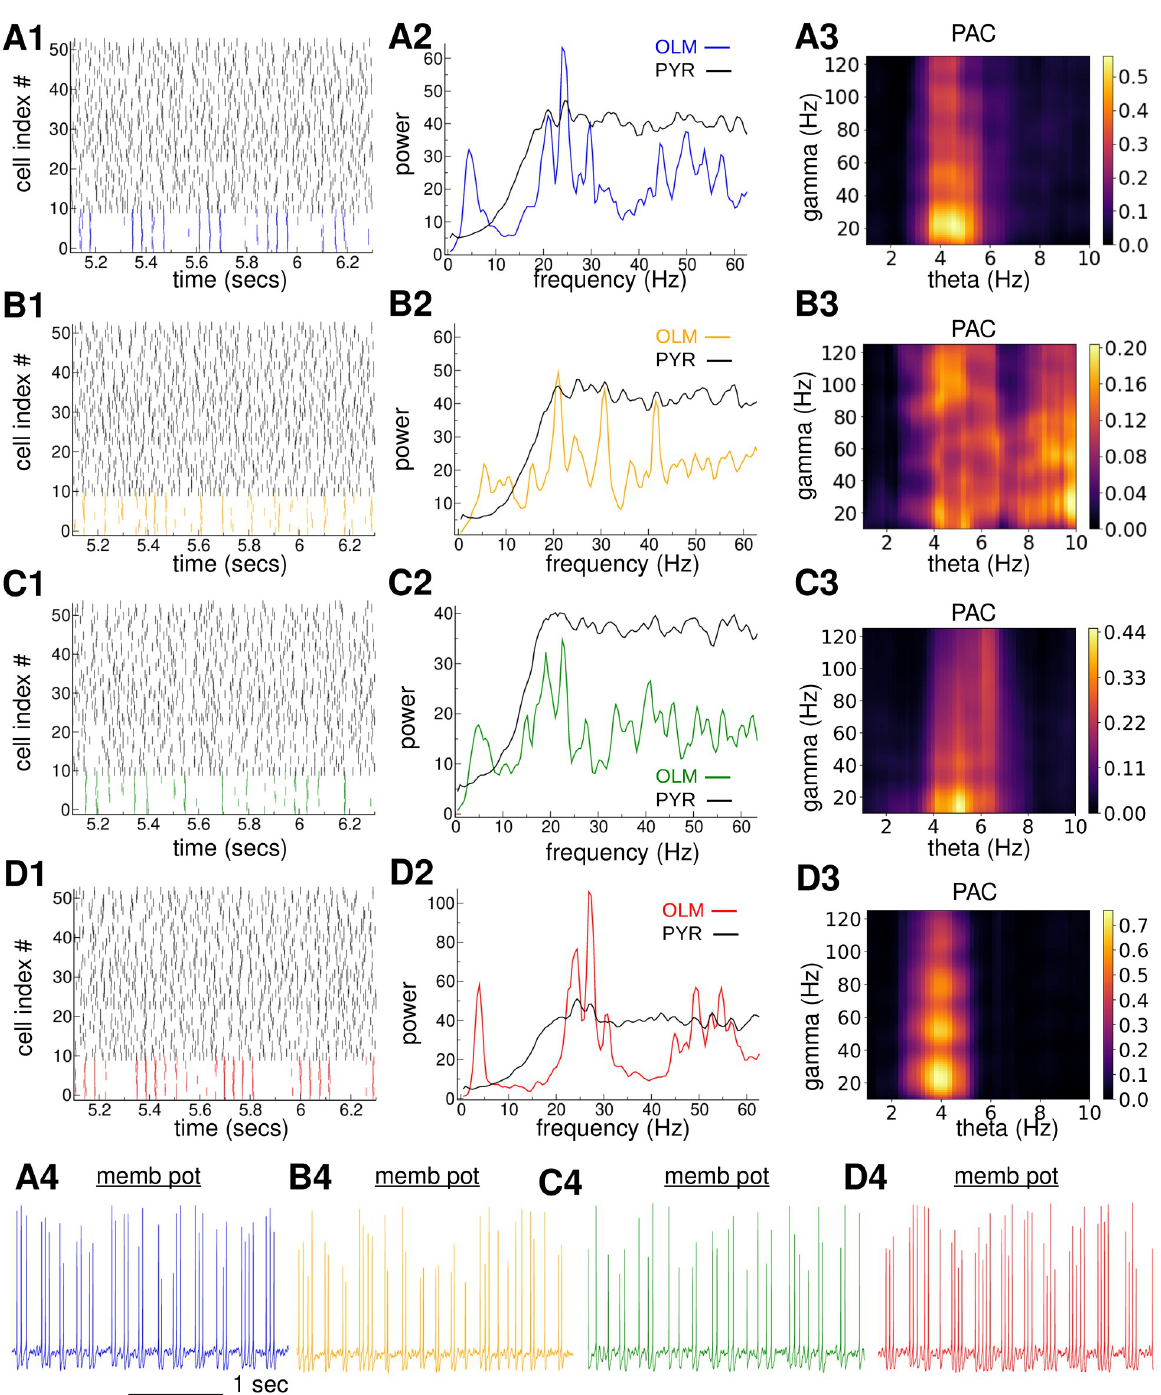
Fig 6. Exemplar simulation of the 120 PYR,10 OLM simplified feedback circuit model at SCIL 178 (indicated by dashed vertical line in Fig 5 ) with (A1-A4) normal strength OLM-PYR synapses, denoted ‘SM’ (blue) , (B1-B4) no OLM-PYR connections, denoted ‘SMx’, (orange) , (C1-C4) strong OLM-PYR synapses and 7 ms GABA decay timescale, denoted ‘SM7’, (green) and (D1-D4) strong OLM-PYR synapses and 25 ms GABA decay timescale, denoted ‘SM25’, (red) . (A1-D1) Raster plot segment showing all 10 OLM (coloured) and 42 of the 120 PYR (black) . (A2-D2) Average individual cell power spectrum for OLMs (coloured) and PYRs (black) . (A3-D3) OLM population activity PAC comodulogram . (A4-D4) Three second membrane potential traces from examplar OLM cells for each model, ‘SM’ (blue), ‘SMx’, (orange), ‘SM7’, (green) ‘SM25’, (red) .